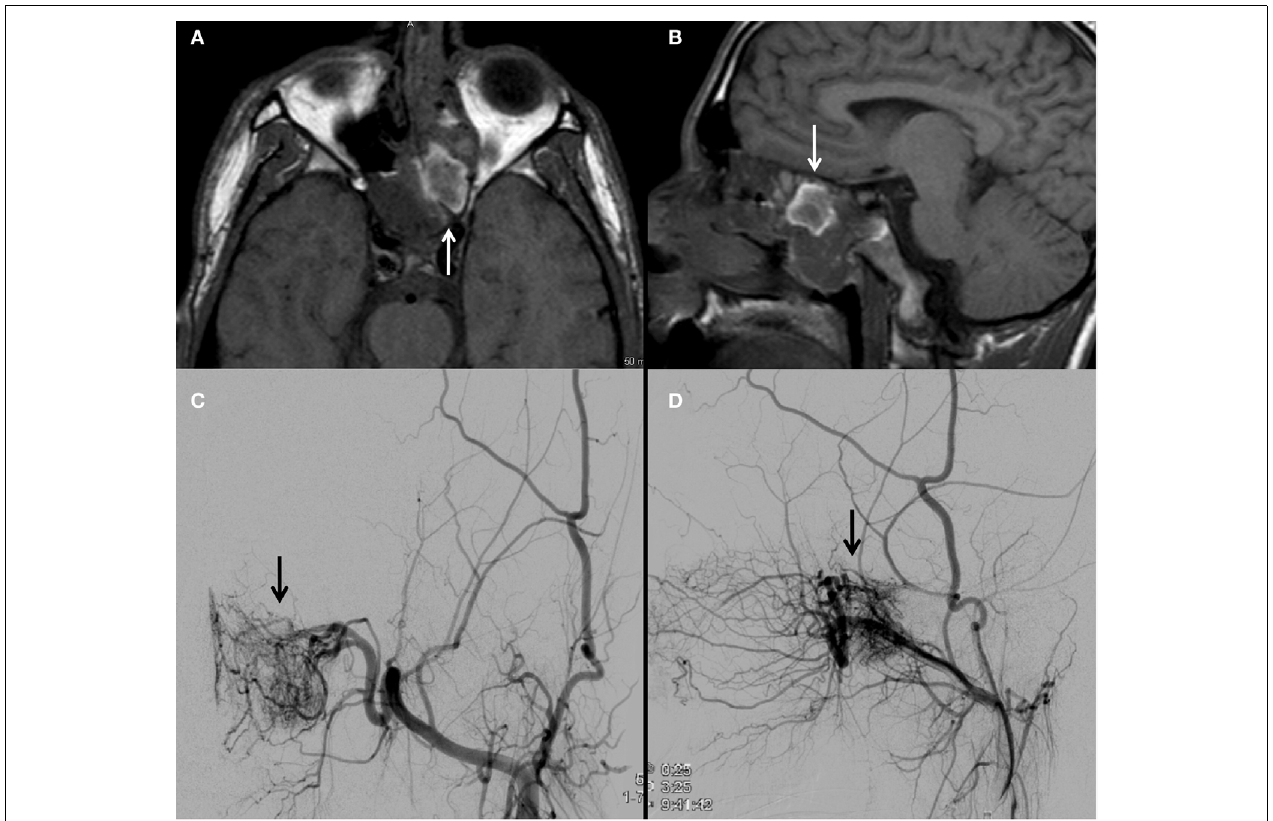
demonstrate a hypervascular lesion (arrows) within the left nasopharyngeal region with predominant blood supply from the artery of the pterygoid canal and posterior nasopharyngeal branches of the distal internal maxillary